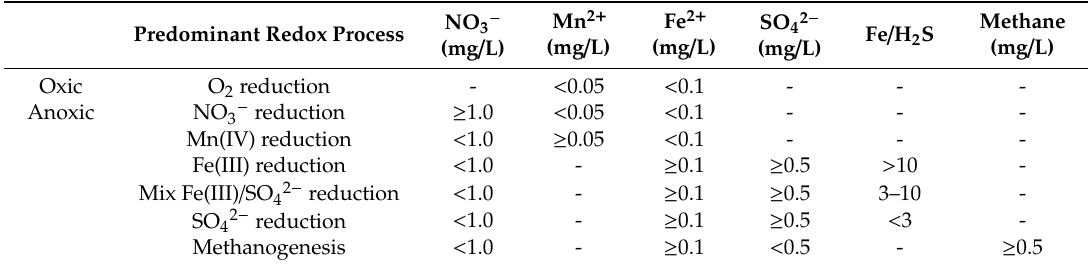
Mn 2 + Fe 2 + NO 3 − (mg / L) (mg / L) (mg / L) < 1.0 > 10